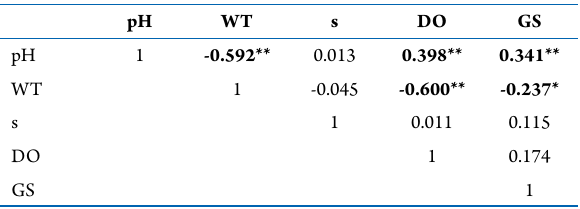
Table 3. Pearson correlation coefficients for environmental variables (boldface indicates significant correlations, **: P < 0.01, *: P <